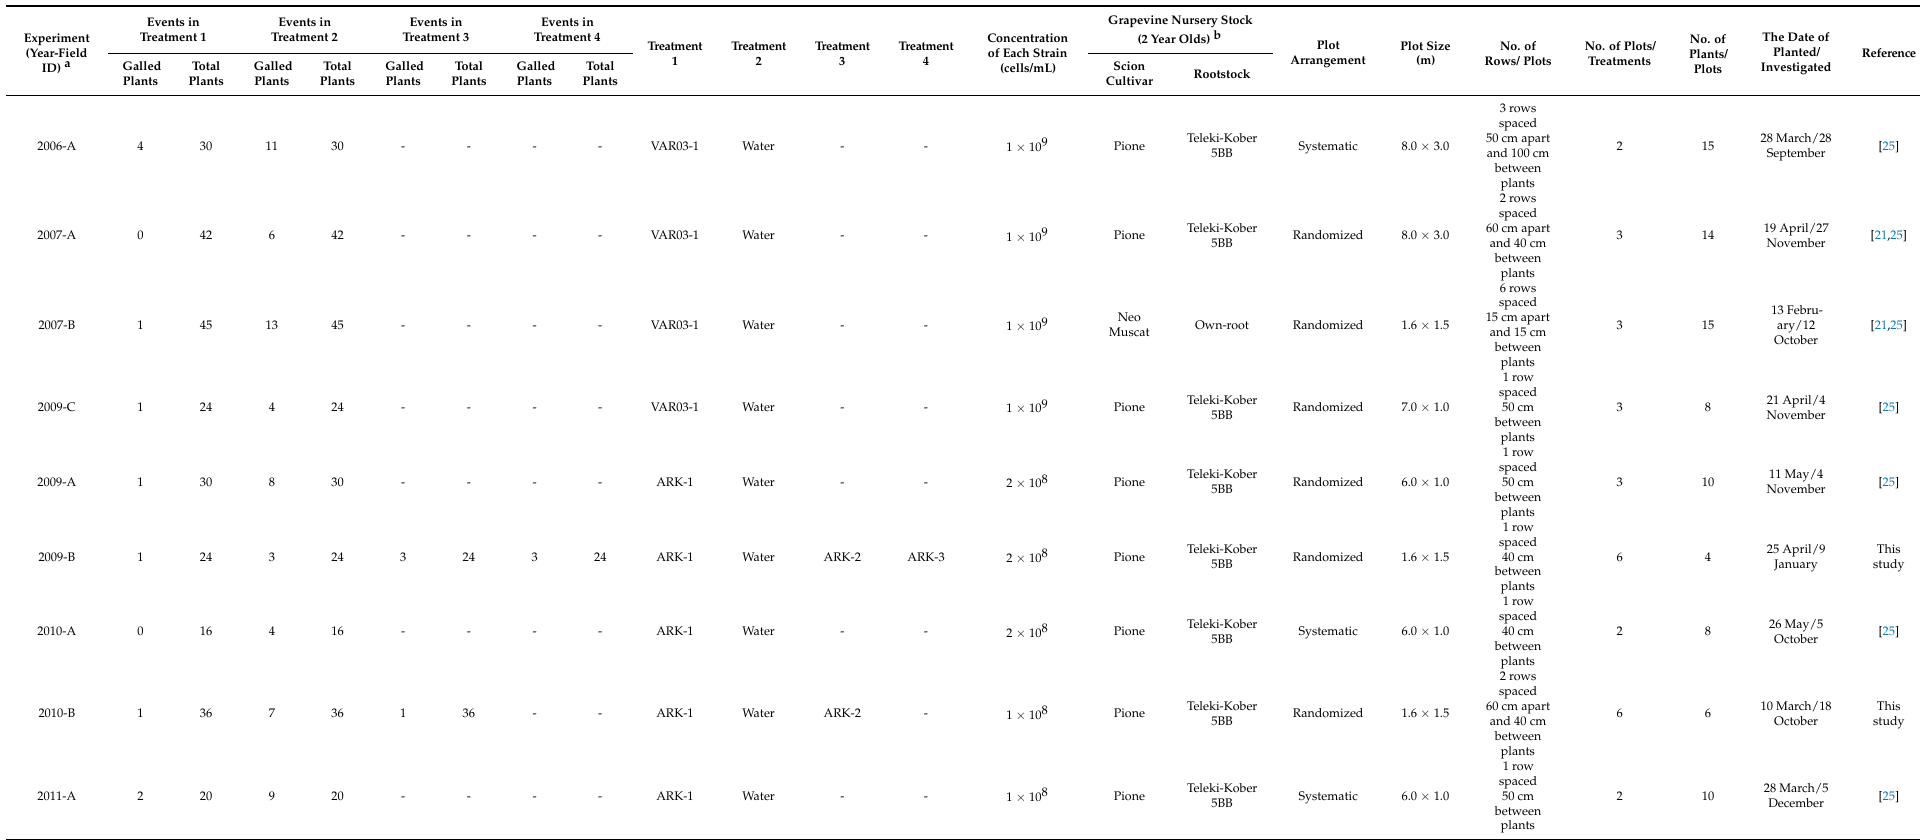
Table 3. Details of the 16 field